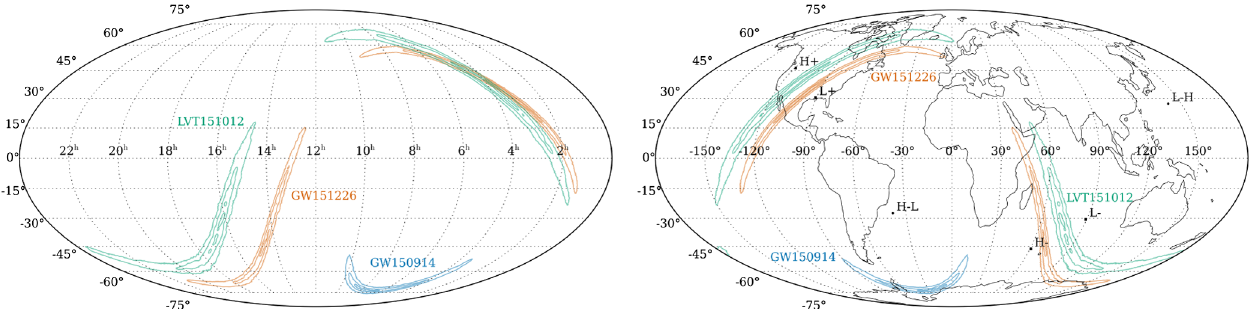
FIG. 6. Posterior probability distributions for the sky locations of GW150914, LVT151012, and GW151226 shown in a Mollweide projection. The left plot shows the probable position of the source in equatorial coordinates (right ascension is measured in hours and declination is measured in degrees). The right plot shows the localization with respect to the Earth at the time of detection. H þ and L þ mark the Hanford and Livingston sites, and H − and L − indicate antipodal points; H-L and L-H mark the poles of the line connecting the two detectors (the points of maximal time delay). The sky localization forms part of an annulus, set by the difference in arrival times between the